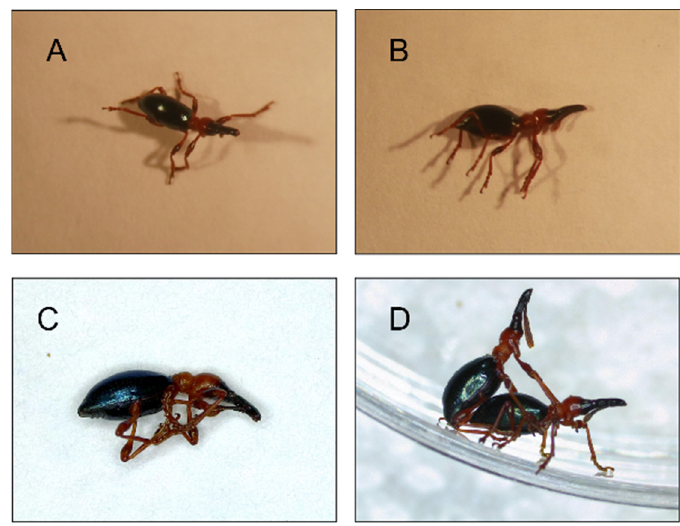
Figure 1. Adult sweetpotato weevil ( Cylas formicarius ): ( A ) resting sweetpotato weevil, ( B ) tonic immobility of the sweetpotato weevil, ( C ) dead sweetpotato weevil, ( D ) courtship in the sweetpotato weevil.